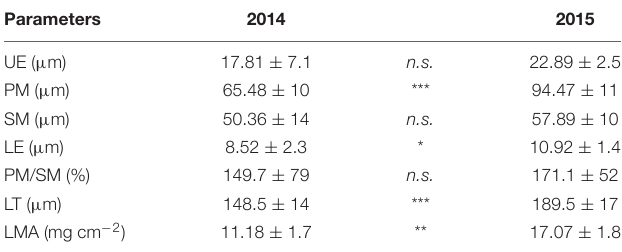
TABLE 2 | Morpho-anatomical traits of C . incanus leaves in July 2014 and